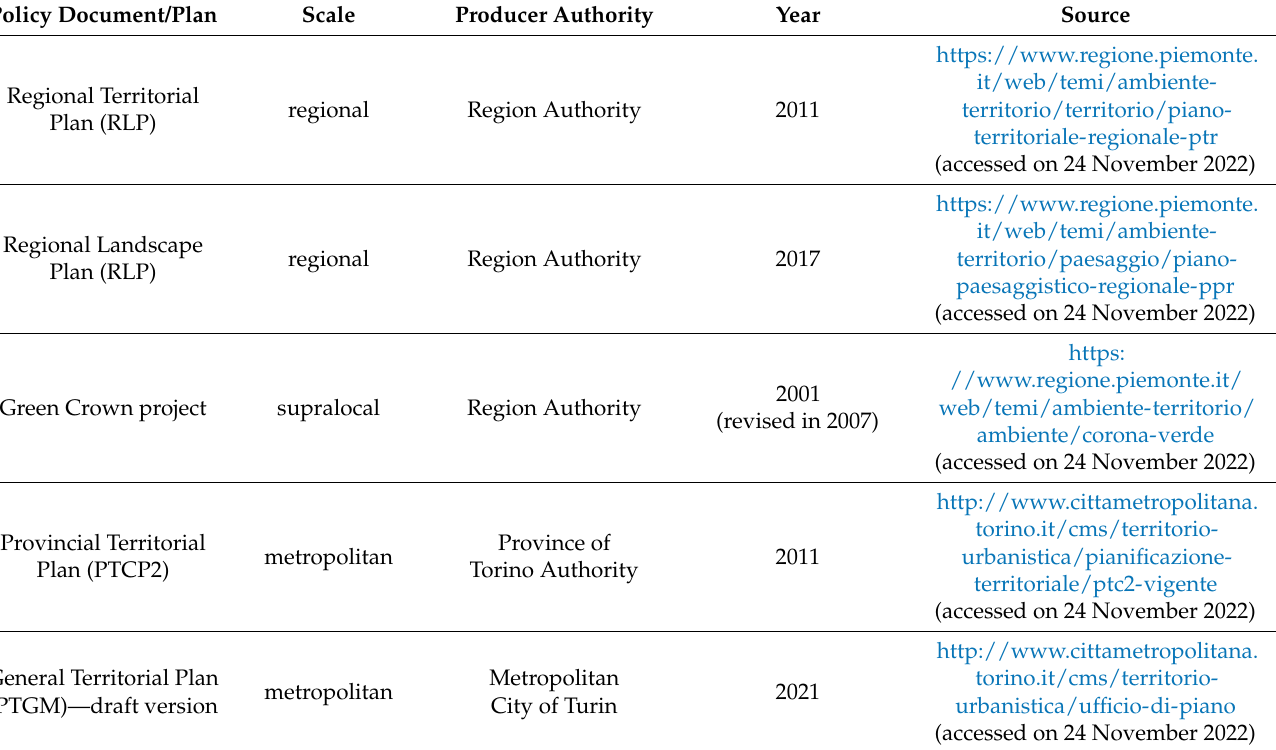
Table 1. Policy documents/plans